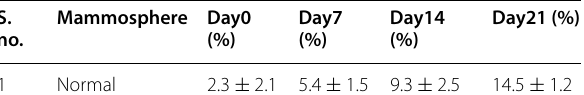
Table 5 CD49f + /EpCAM − stem-like cell population in mammospheres from normal breast